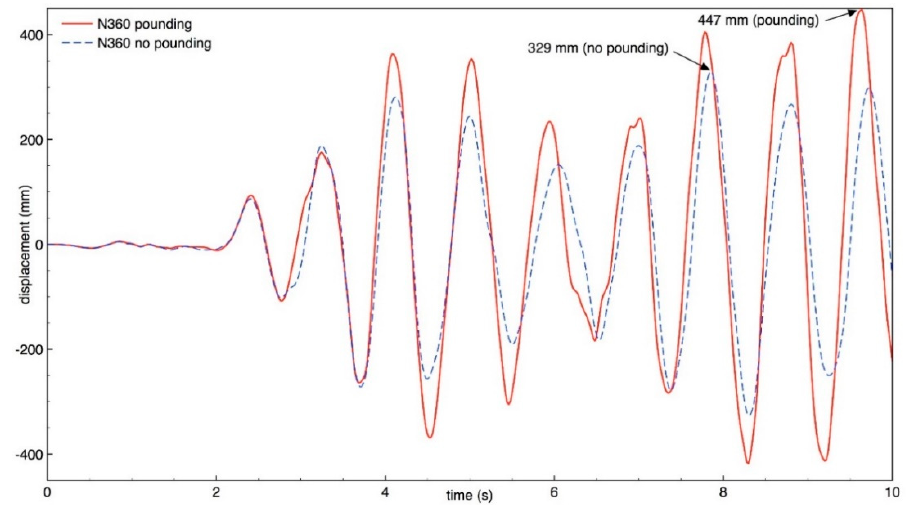
Figure 10. Longitudinal response of building A (node N360) with and without pounding.